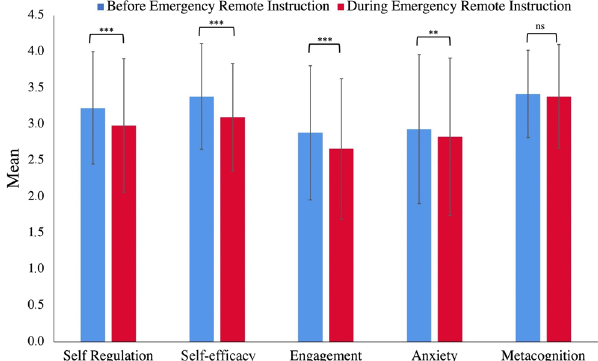
FIG. 6. Mean values of the raw scores of the five latent factors of the PAOI questionnaire before and during emergency remote instruction. Whiskers indicate standard deviation. ** p < 0 . 01 ; *** p < 0 . 001 ; ns ¼ nonsignificant. All factors reflect the capability to control a specific aspect of the academic orientation towards physics. For instance, the anxiety factor refers to how well students were able to cope with this emotional state.